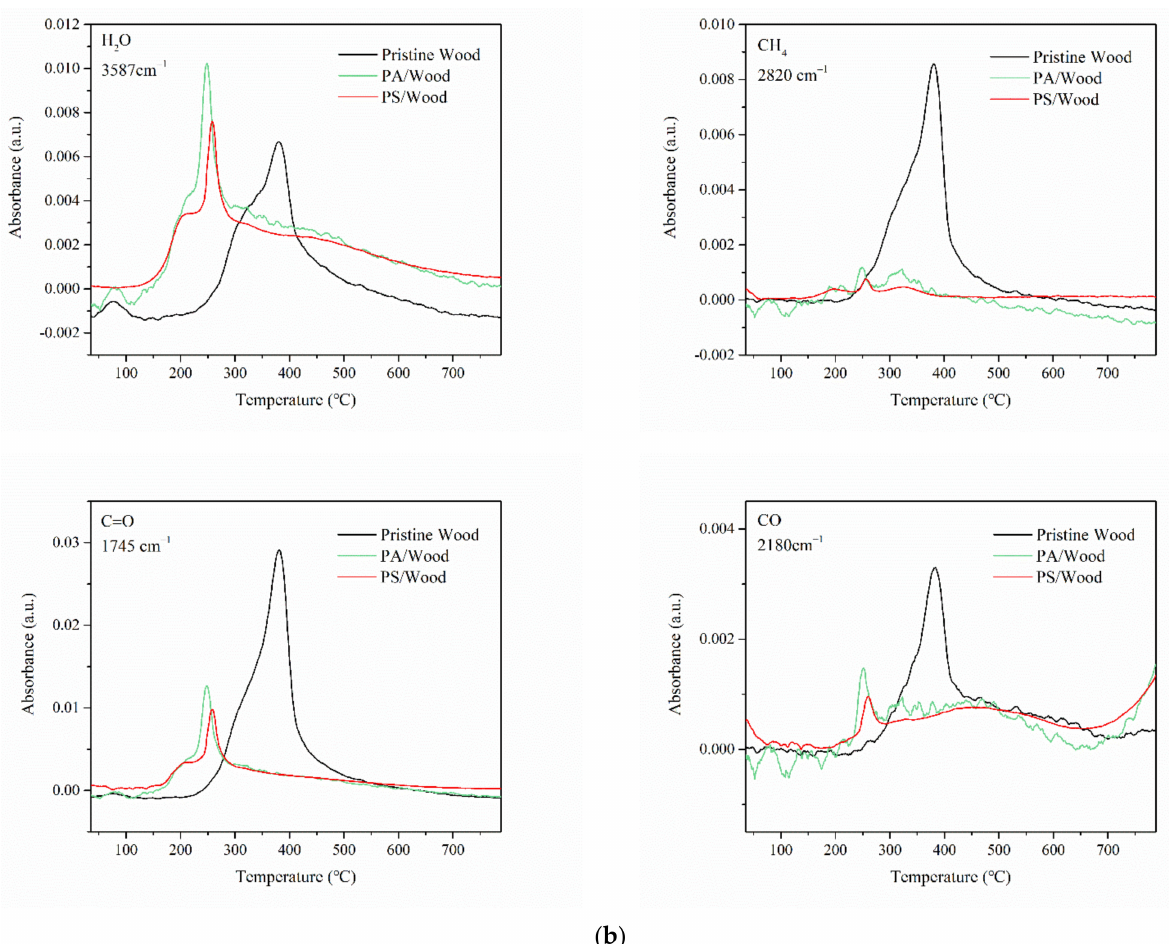
Figure 10. FTIR spectra of ( a ) the evolved gases, and ( b ) contents of H 2 O, CH 4 , C=O and CO produced during the whole pyrolysis process of the wood